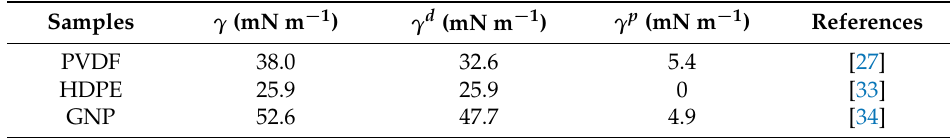
Figure 1. Scanning electron microscope (SEM) images of selected samples: ( a ) F7E3, ( b ) F7E3-1 (higher magnification image included in the inset), ( c ) F7E3-2, and ( d ) F7E3-3. Table 1. Surface tension data of PVDF, HDPE, and GNP at 190 ◦